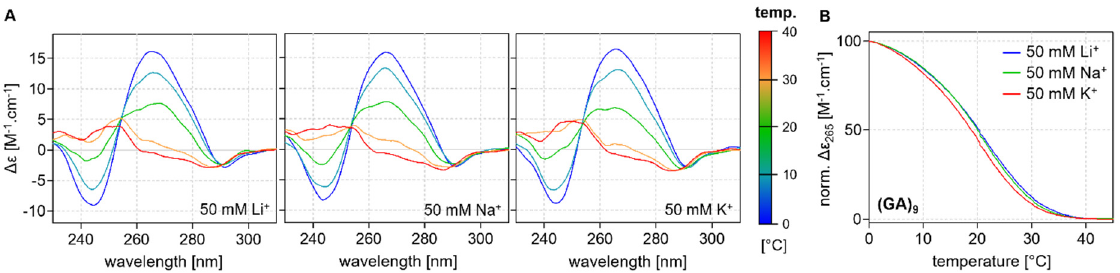
Figure 5. ( A ) CD profiles of (GA) 9 at various temperatures with increments of 10 °C in the presence of different ions ( B ) Corresponding melting curves obtained at 265 nm: 50 mM LiCl (blue), NaCl (green), and KCl (red).